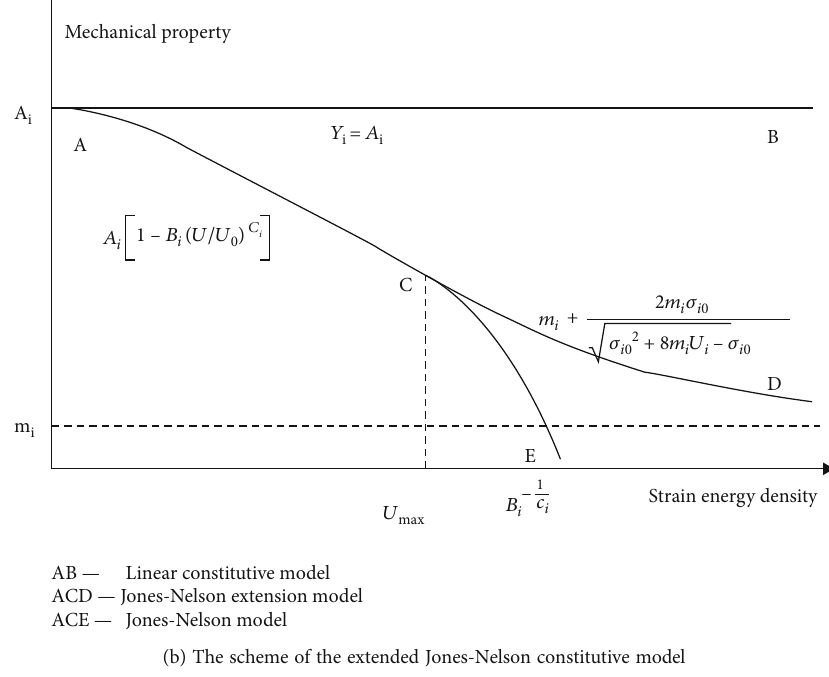
Figure 2: The extension of Jones-Nelson